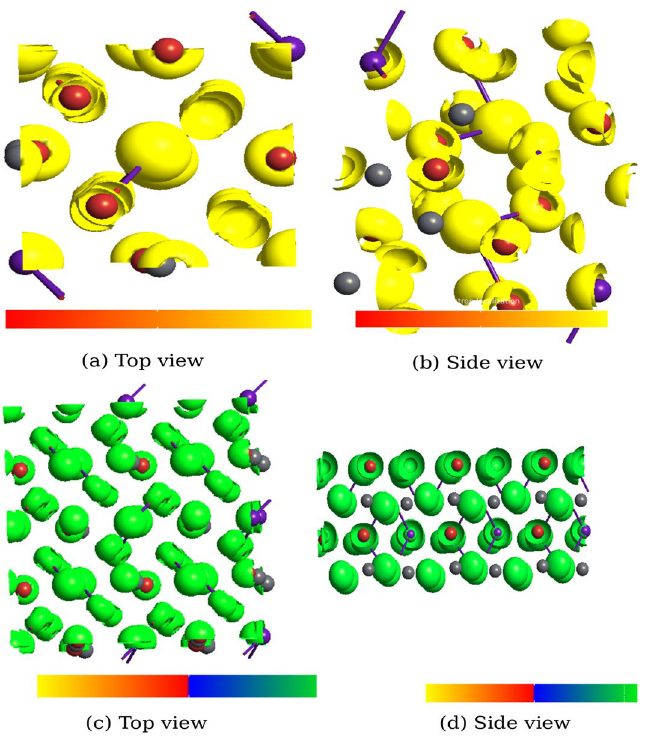
Figure 5. ( a , b ) Top-side view of 3D electron density map of bulk orthorhombic CrPbBr 3 and ( c , d ) Top-side view of 3D electron density map of 001-surface of CsPbBr 3